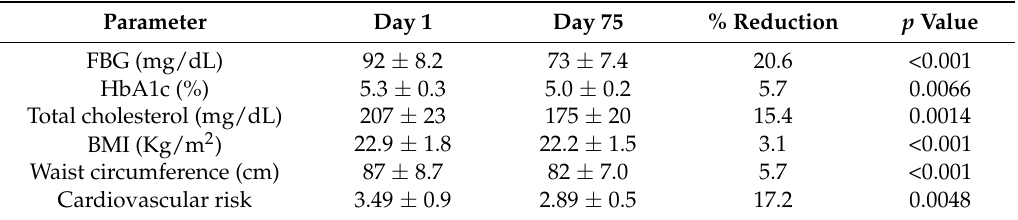
Table 4. Pre- vs. post-treatment comparison of the metabolic parameters explored in 10subjects treated for 75 days with the ABA-rich food supplement.